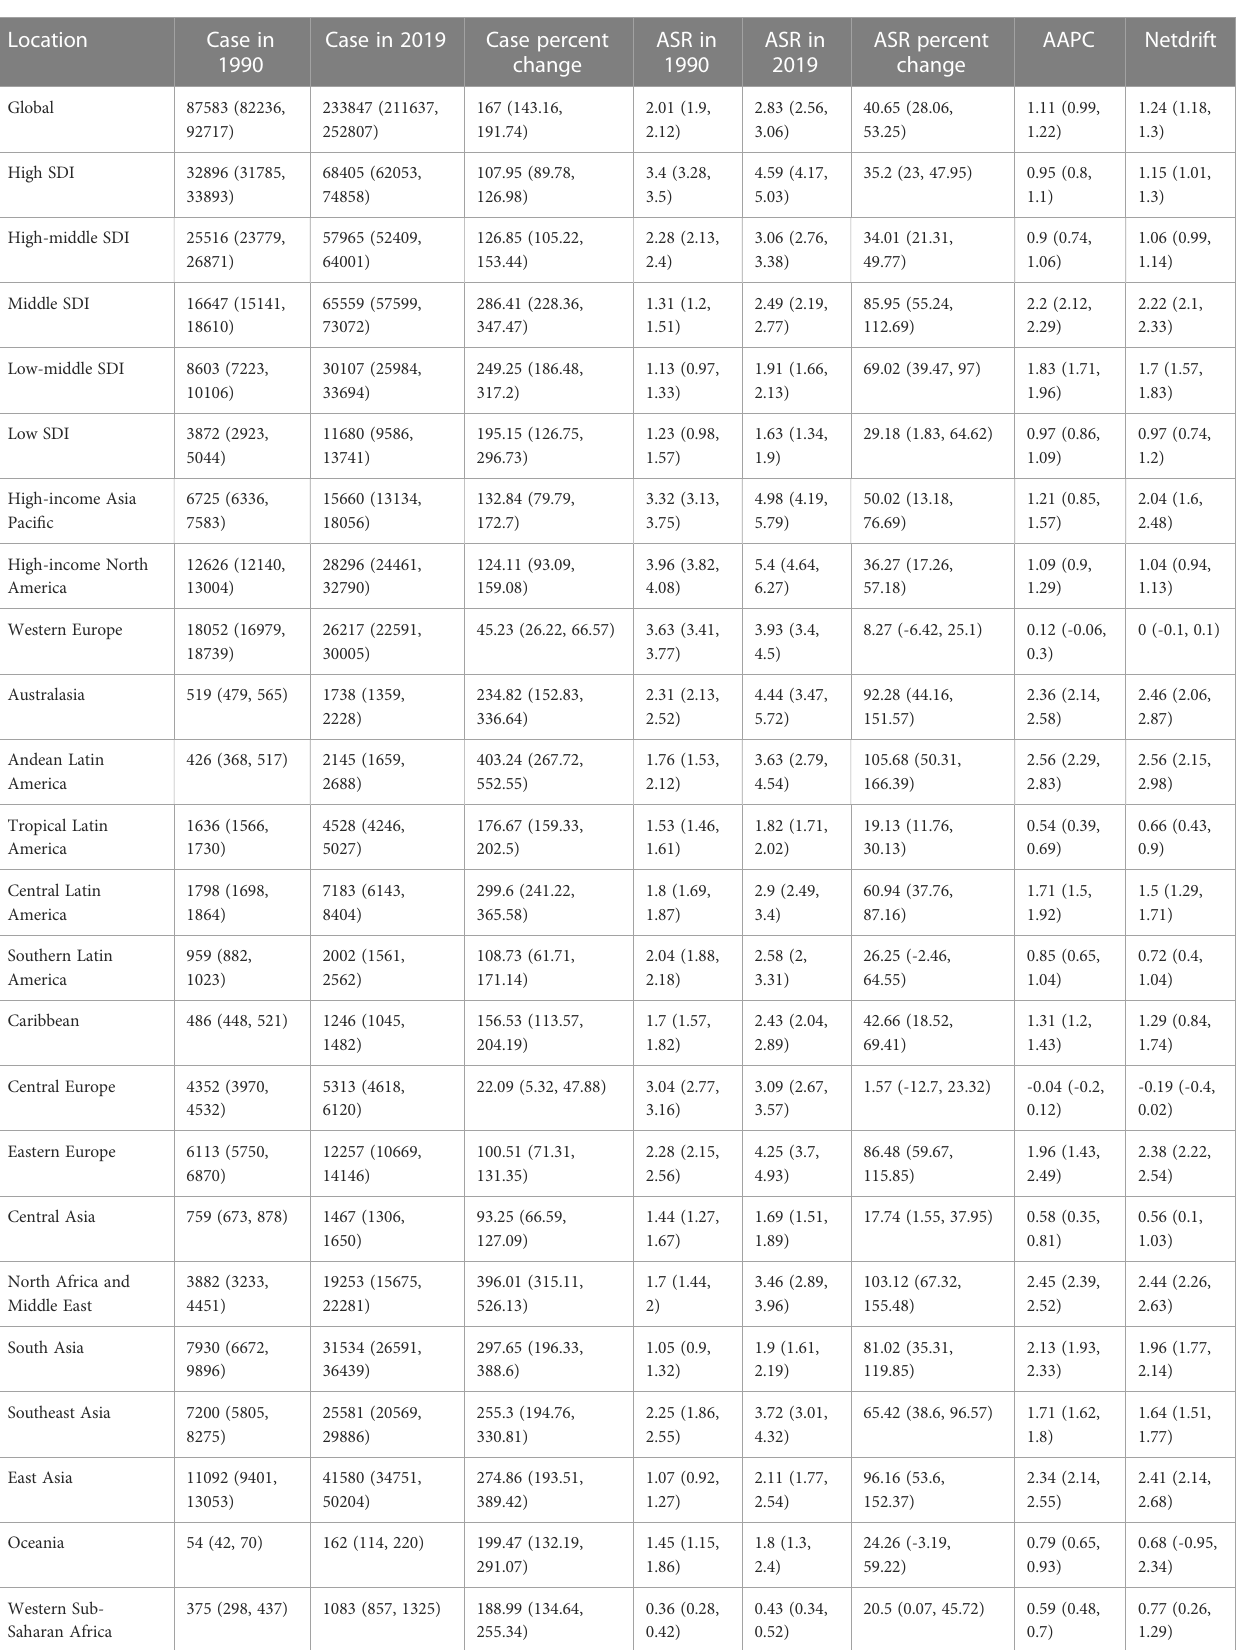
TABLE 1 Trends in TC incidence across socio-demographic index quintiles, 1990 −